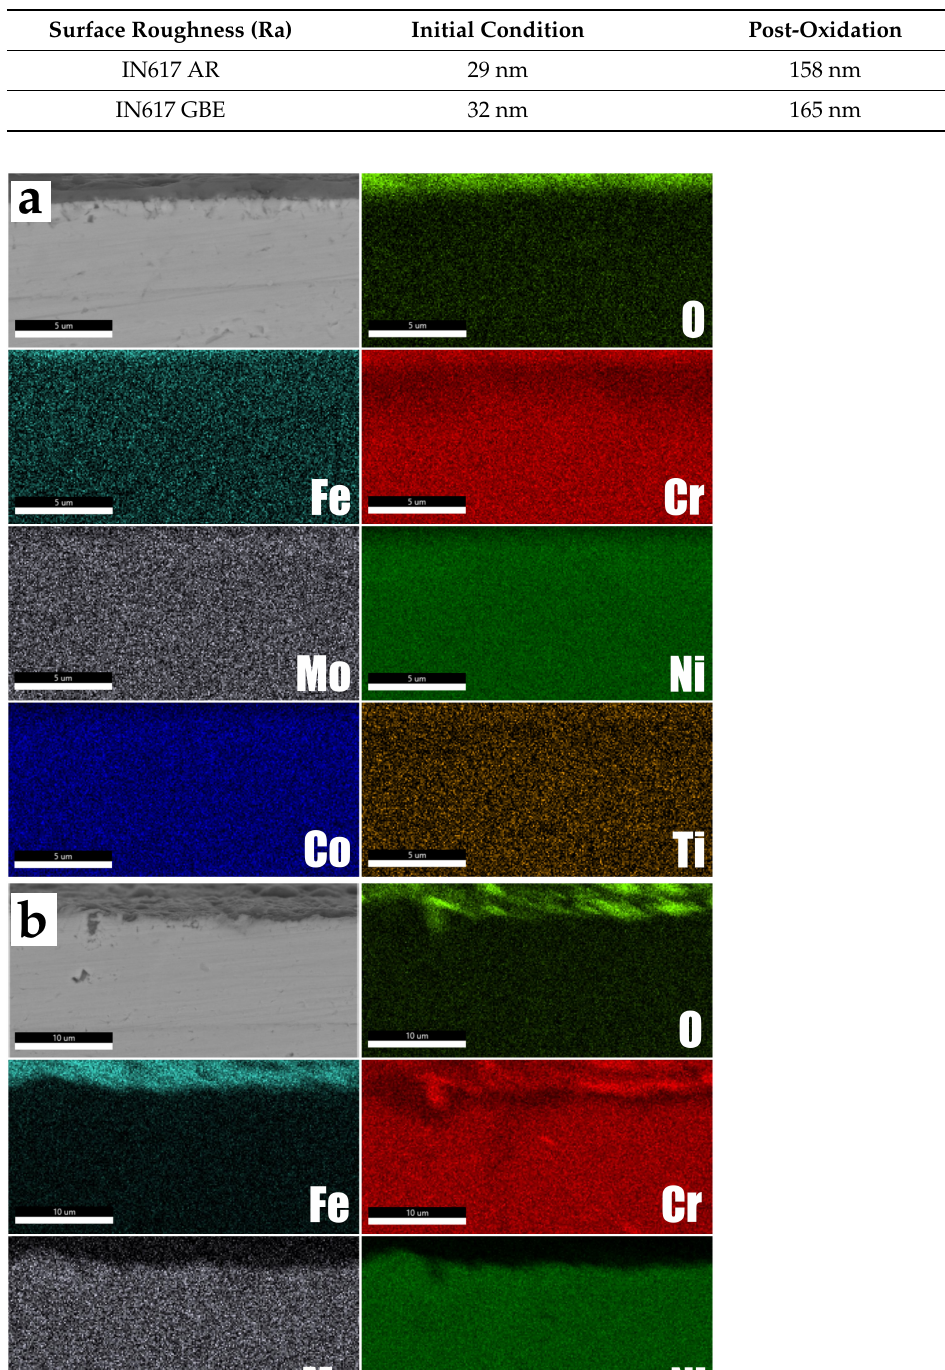
Table 4. Surface roughness of steam-oxidised IN 617 AR and IN 617 GBE sample.